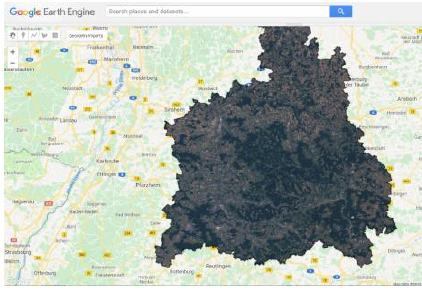
Figure 2: Landsat 8 image of